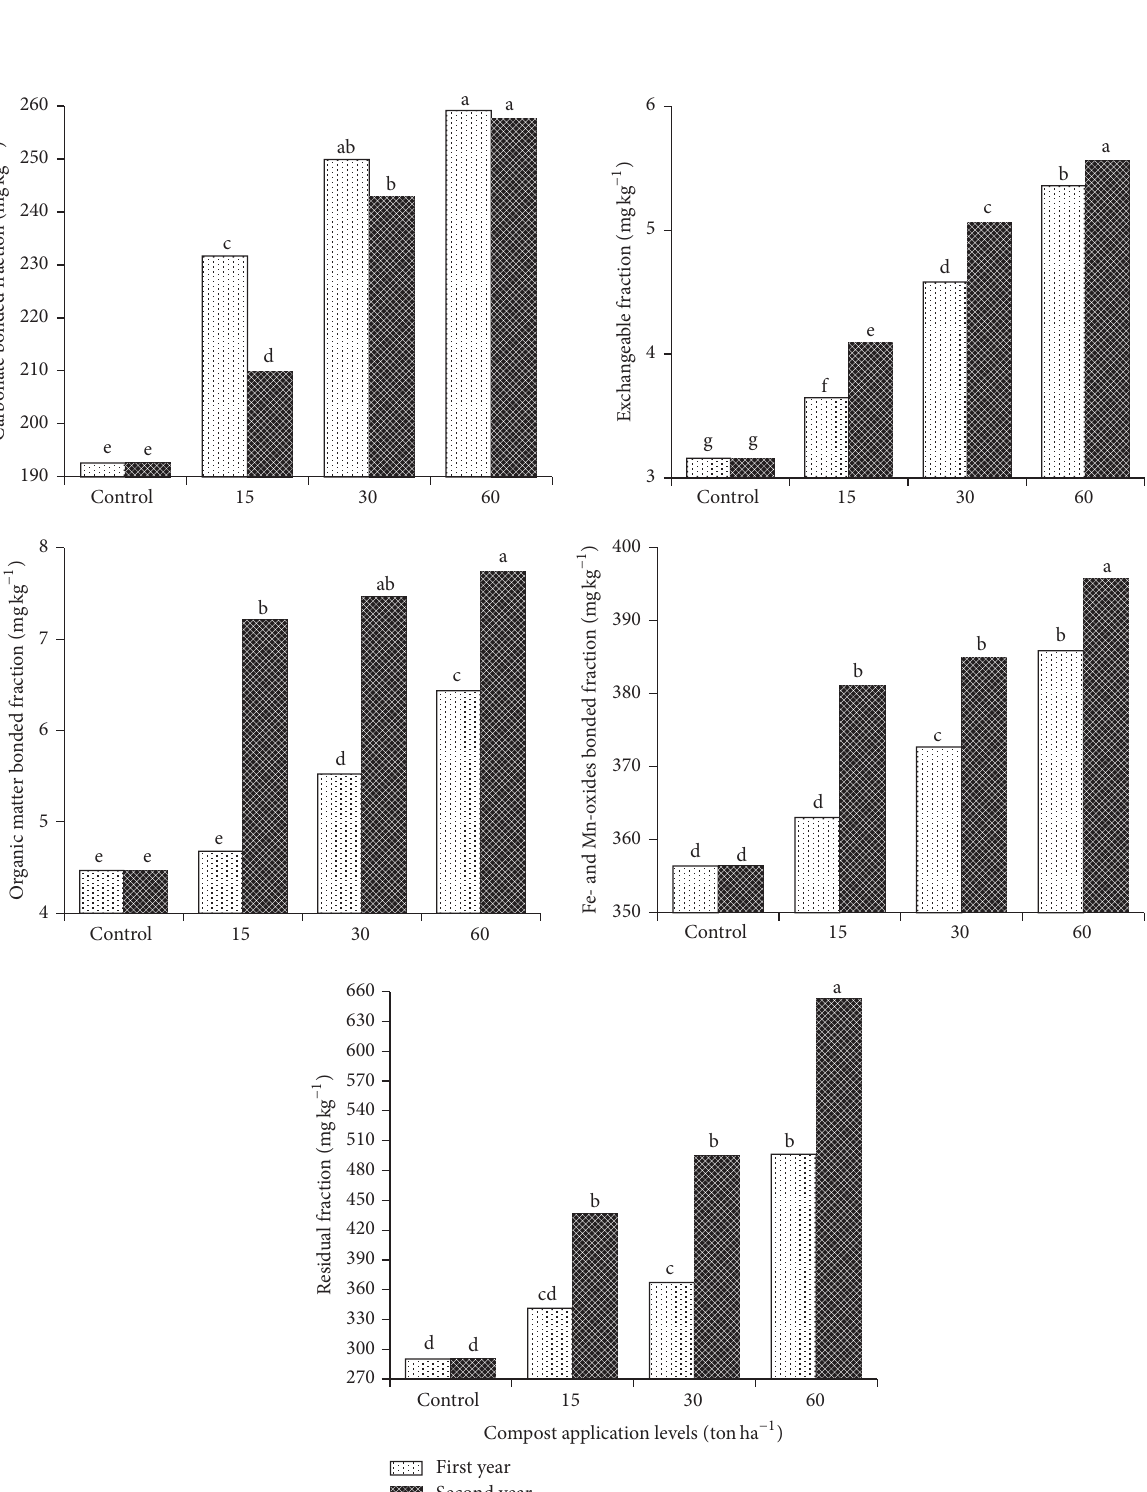
Figure 1: Effect of interactions between compost application levels and compost application times over two consecutive years on various components of manganese concentration in soil. Letters a–g indicate significant difference between means according to Duncan multiple range test at 5% probability